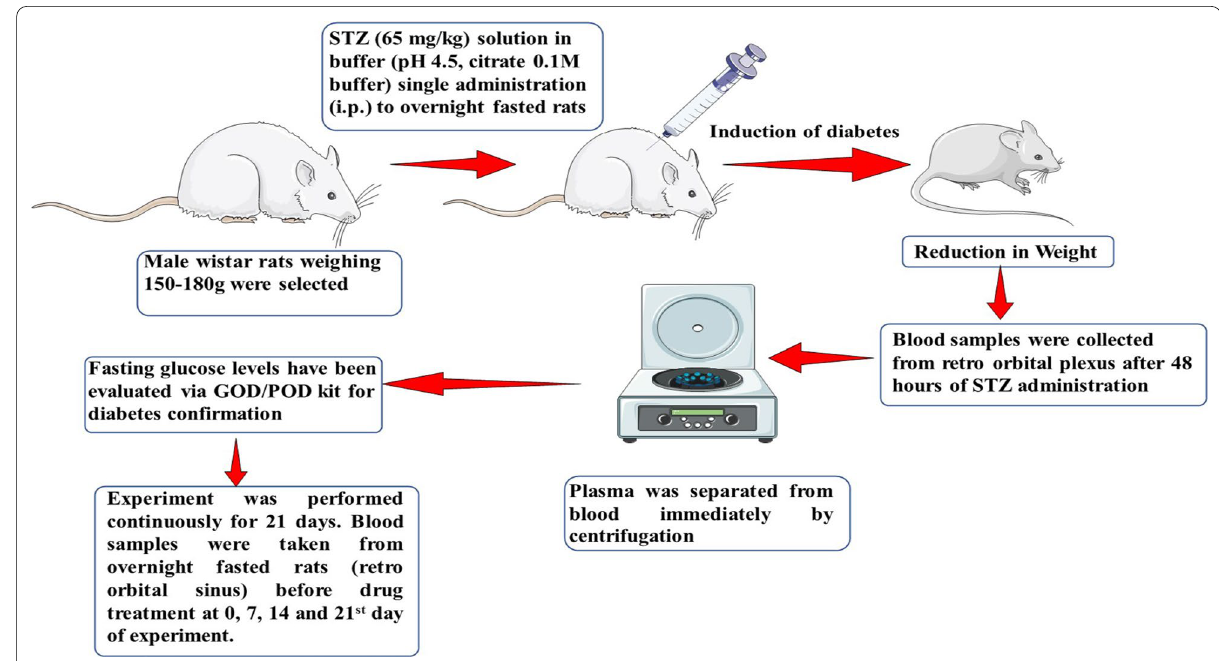
Fig. 5 Procedure of antidiabetic activity